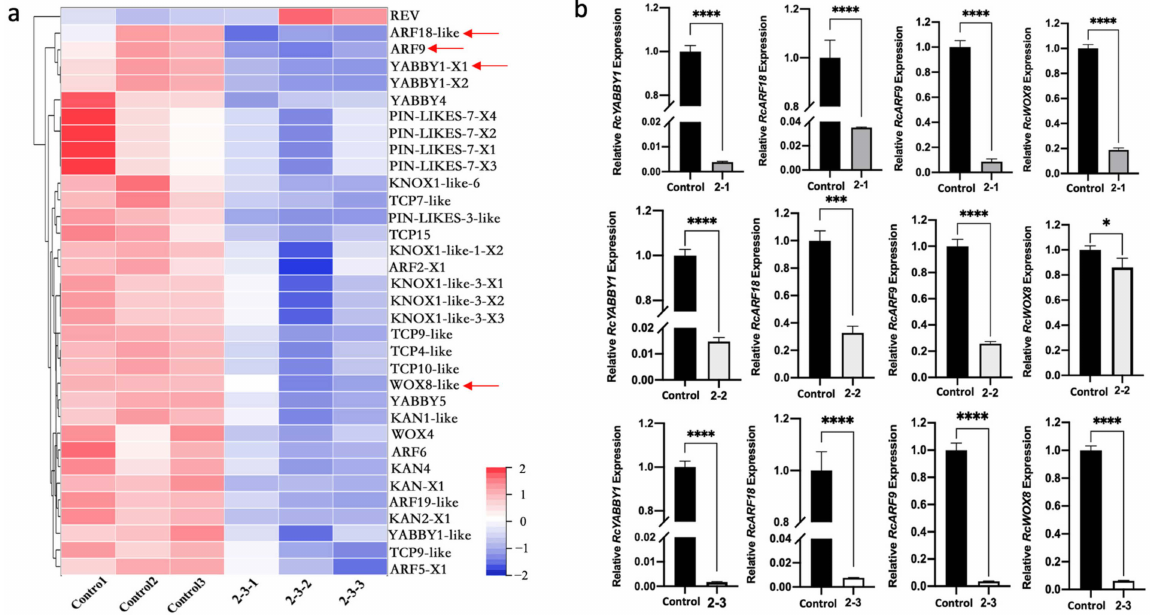
Figure 5. Screening and expression analyses of differentially expressed genes (DEGs) related to leaf development and morphogenesis: ( a ) heat map analysis of DEGs (between 2-3 and control) associated with leaf development and morphogenesis; genes used for the qPCR validation are marked with arrows; ( b ) qPCR analysis of DEGs. Asterisks indicate significant differences among treatments (* p < 0.05; *** p < 0.001; **** p < 0.0001). The vertical bars indicate the standard deviations of the means of three